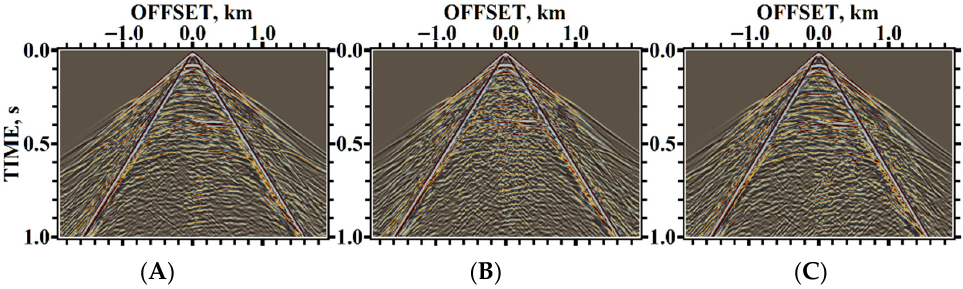
Figure 38. Example #5, seismograms, vertical component of velocity: ( A ) «without fractures»; ( B ) «fractured zone #1»; ( C ) «fractured zone #2».